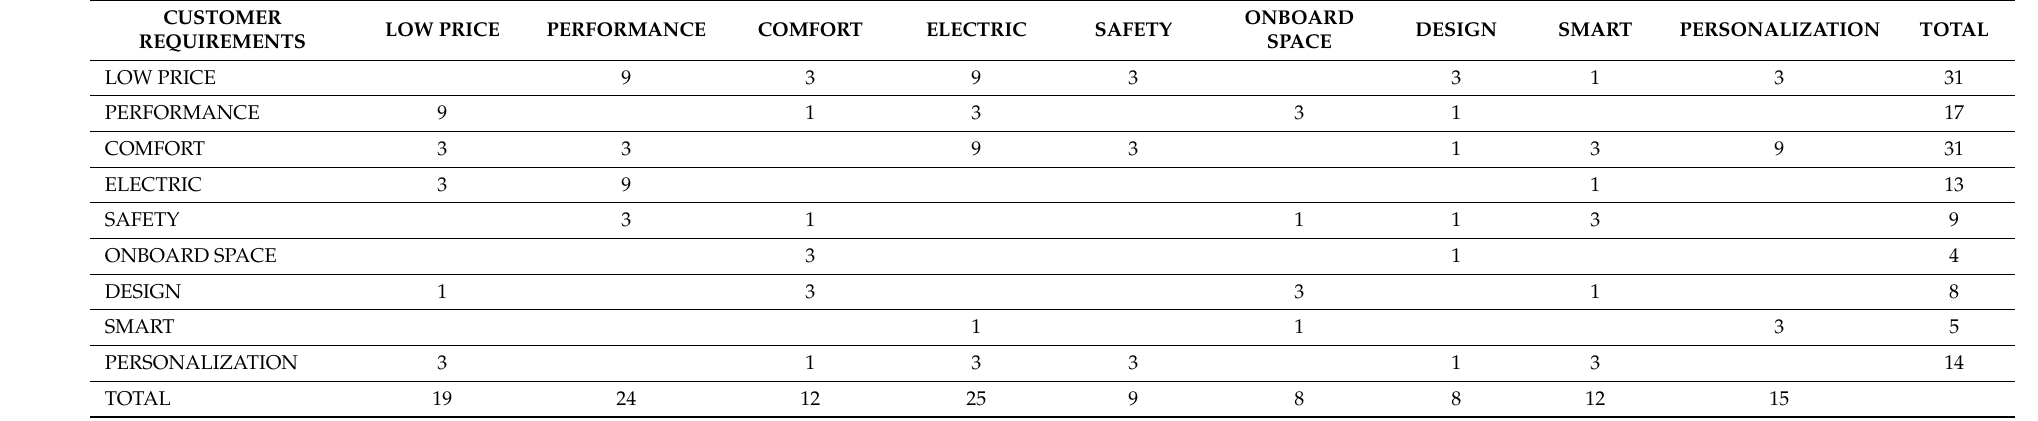
Table 3. Dependency matrix for customer